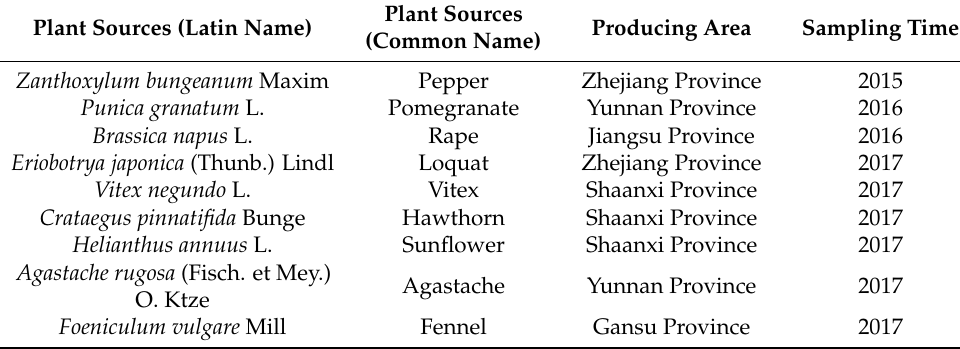
Table 1. The information of 9 species of unifloral Chinese honey samples.